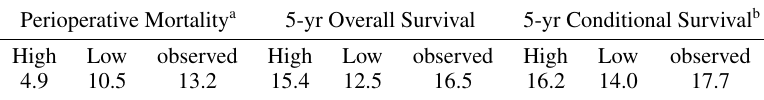
Table 3: Comparison of survival in pancreatic cancer patients in high and low volume mortality rates(6) to those within our health system.